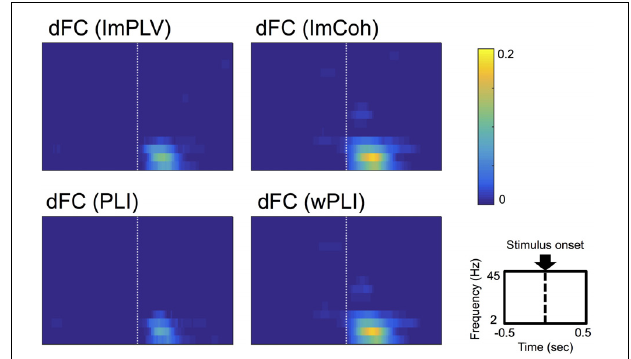
FIGURE 3 | Grand-averages of double-thresholded functional connectivities (dFCs) across all the datasets. As shown in the rightmost-bottom panel, each panel shows data in the time range (abscissa) of 0.5 s before to 0.5 s after the stimulus onset (0 s) and in the frequency range (ordinate) between 2 Hz and 45 Hz. Note that each pixel value represents a proportion of the corresponding pixel to be in significant clusters among all 250 sets of random sampling and all datasets.